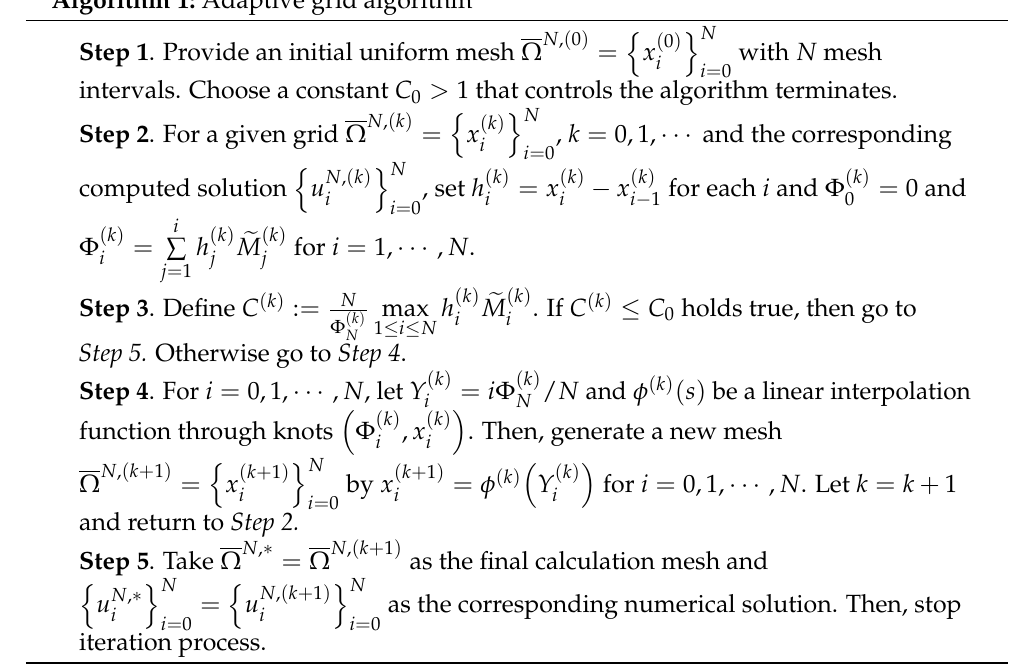
Algorithm 1: Adaptive grid